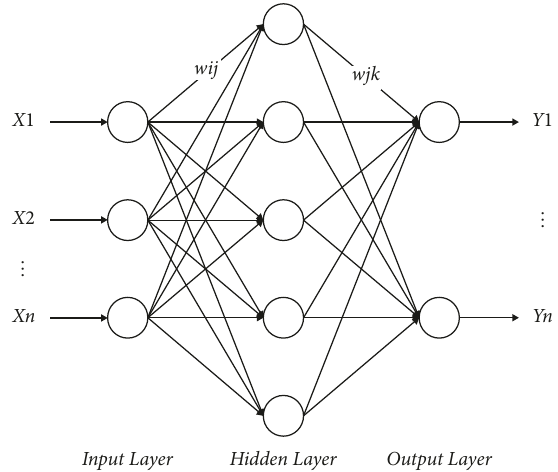
Figure 5: BP neural network